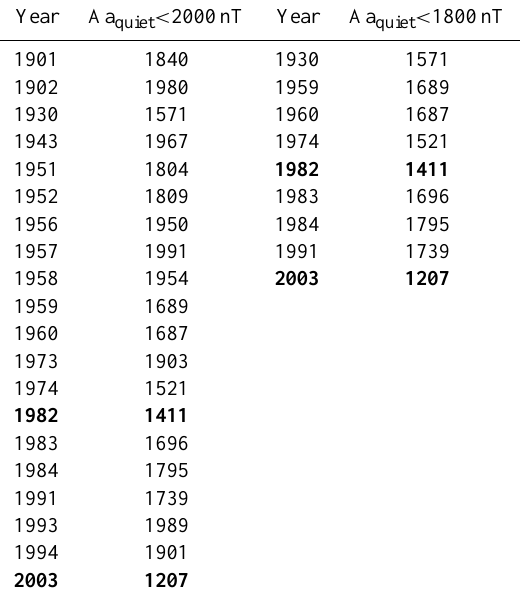
Table 1. Years from 1868 until now with Aaq values smaller than 2000nT (column 2) and 1800nT (column 4); columns 1 and 3 are years (see text for further